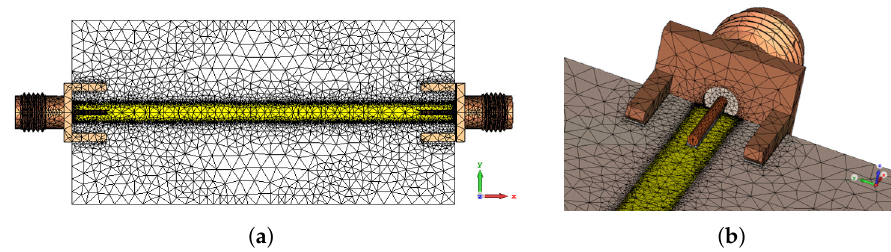
Figure 8. Discretization of 3D models. ( a ) Discretization of complete PCB. ( b ) Discretization of SMA-to-microstrip interface.